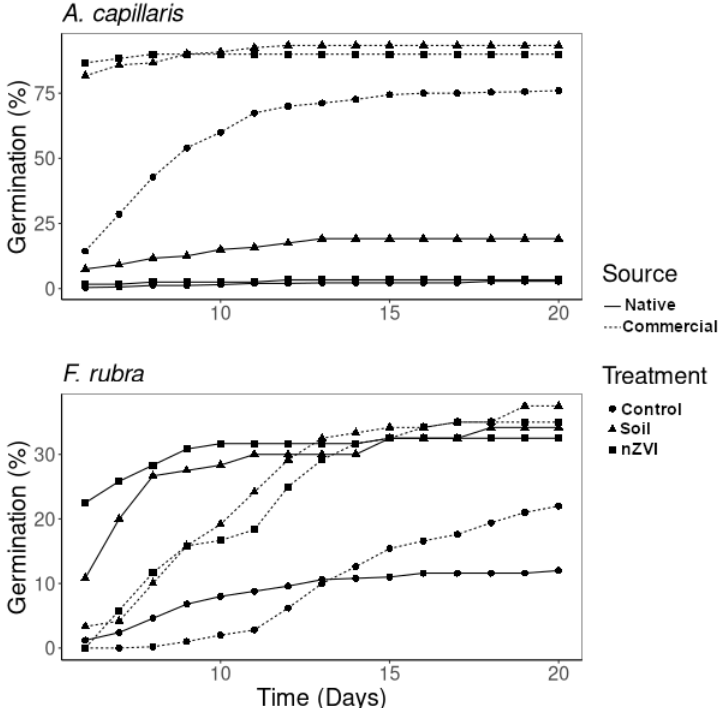
Figure 1. Evolution of total seed germination (%) with time (from day 6). Treatments: control, contaminated soil, and contaminated soil + 1% nZVI. Source of the seeds: native from contaminated site and commercial.